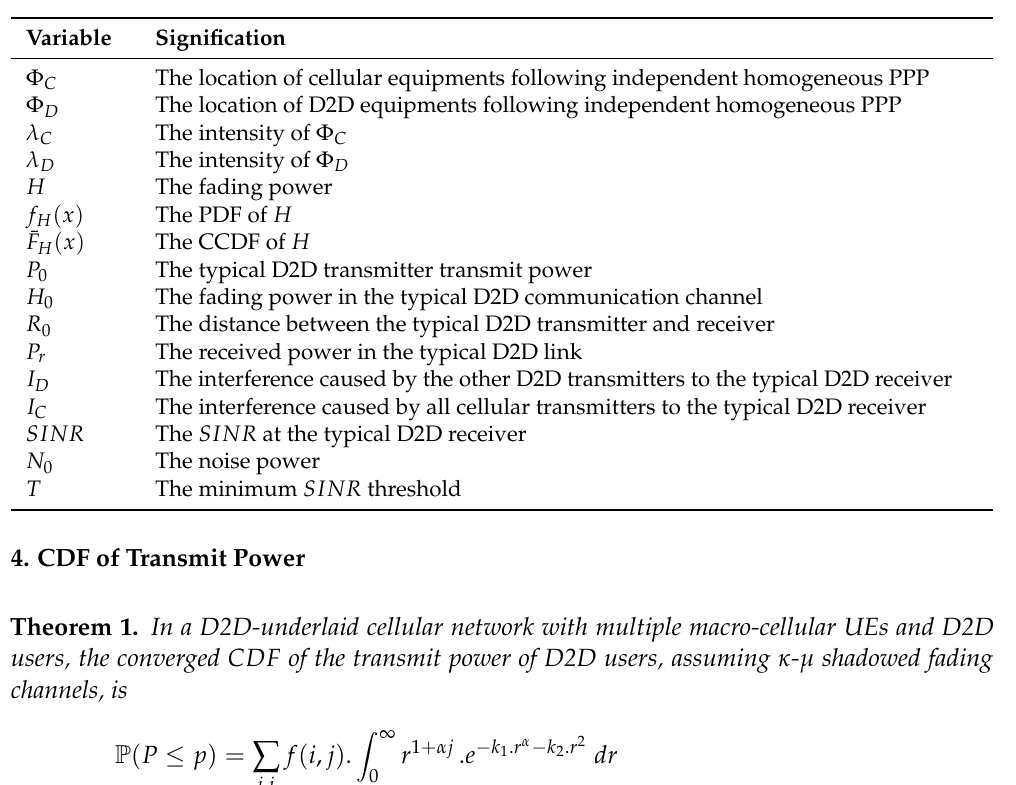
Table 3. List of